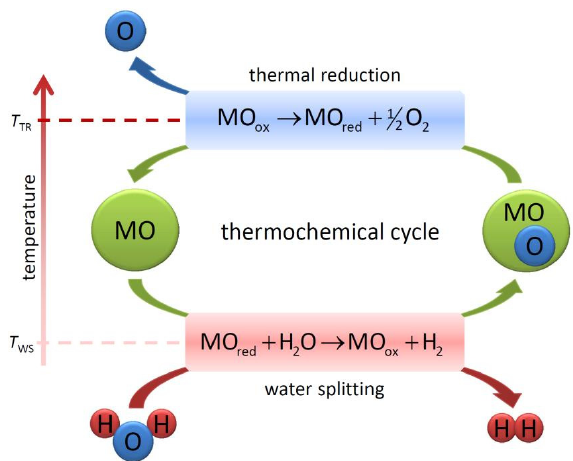
Figure 10. Two-step metal redox system for hydrogen generation [108].